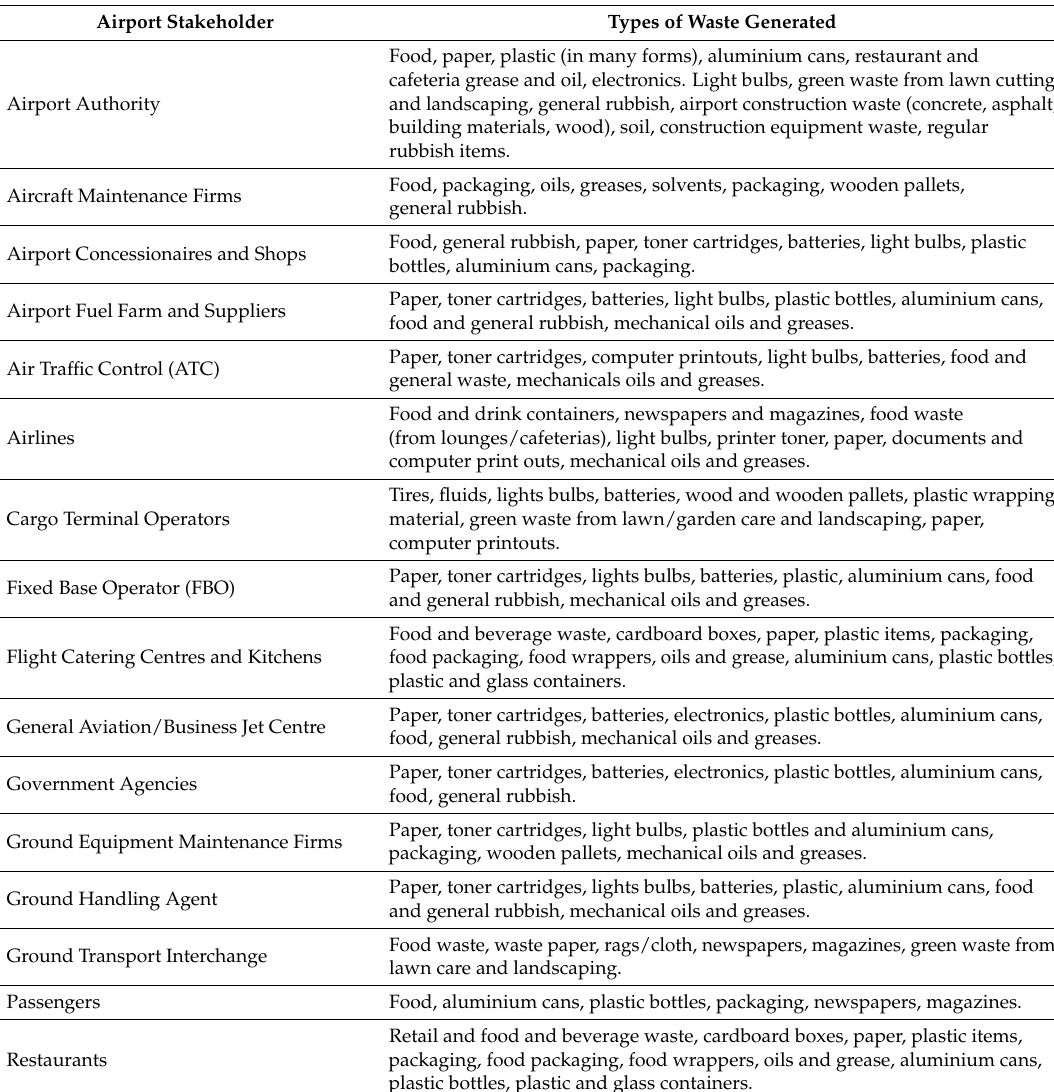
Table 2. Key airport airside stakeholders and typical types of waste